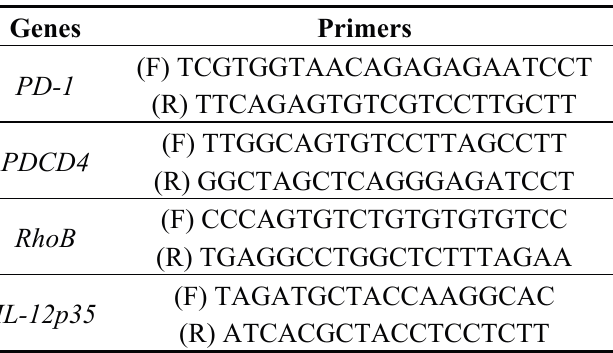
Table 3. The used primers for reverse transcription PCR (RT-PCR) and real-time quantitative